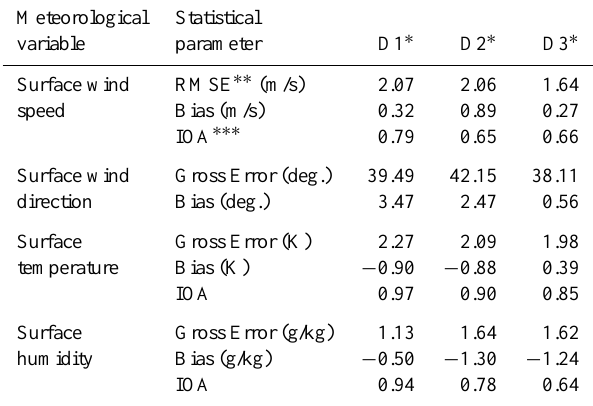
Fig. 4. Comparison of observed and simulated NO 2 at the Luhu, Wanqingsha, and Donghu sites.